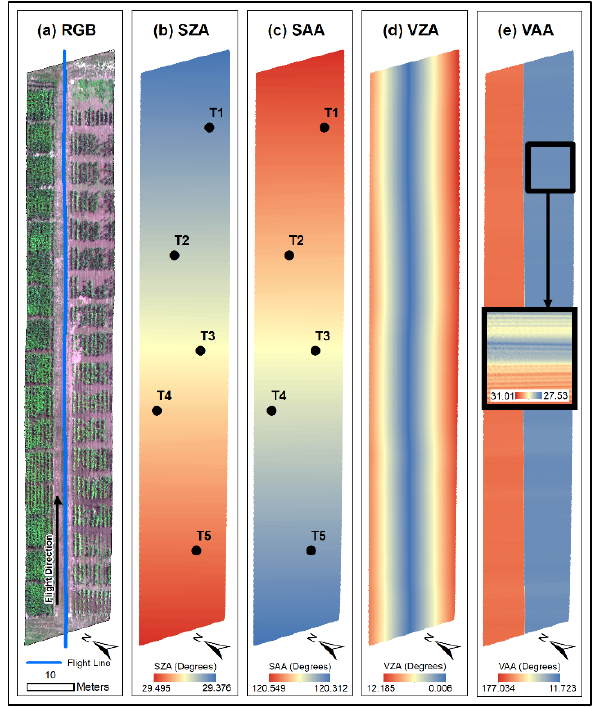
Figure 3 . Resulting angles for the 1 st HSI cube, where (a) RGB true color composite, (b) solar zenith angle (θ S ), (c) solar azimuth angle (ϕ ), (d) viewing zenith angle (θ V ), and (e) S viewing azimuth angle (ϕ ). The black dots (in b and c) are test V points that were verified with alternative source. The inset map in the VAA (e) shows a small zoomed-up portion, which indicates the changing angular pattern in